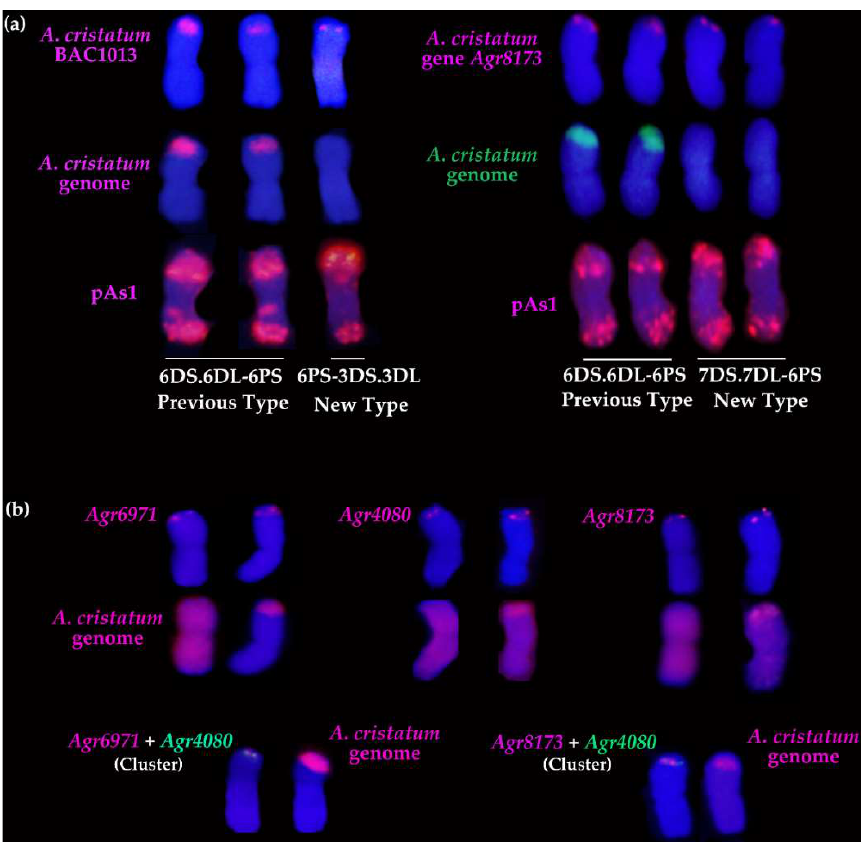
Figure 5. The production of the new types through the introgression and the physical positions of the three genes on A . cristatum 6PS (0.81–1.00) in the translocation line WAT655. ( a ) The new translocated types were produced through the introgression between A . cristatum P genome and wheat genome. The probes BAC1013, Agr8173 , and pAs1 were in red; the probes made from A . cristatum P genomic DNA were in red or green. ( b ) The physical positions of the three genes Agr6971 , Agr4080 , and Agr8173 on A . cristatum 6PS (0.81–1.00). The probes Agr6971 , Agr8173 , and the probe made from patterns of chromosomes in ( a , b ) are from Figure 4 and Figures S2–S4.